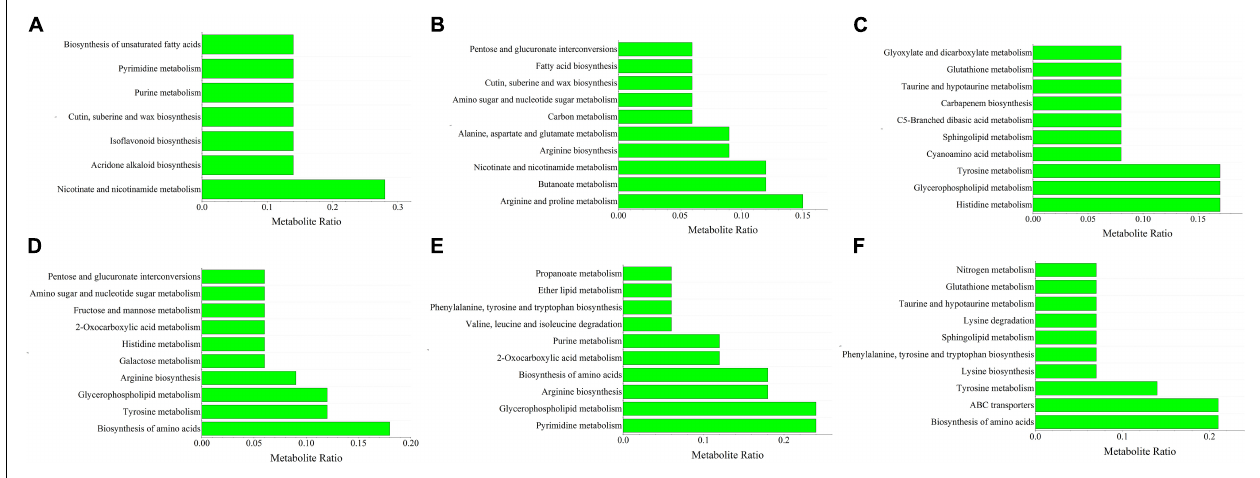
FIGURE 4 | Top 10 metabolites ratio of S1 vs. S22 (A) , S1 vs. S28 (B) , S1 vs. S49 (C) , R1 vs. R22 (D) , R1 vs. R28 (E) , and R1 vs. R49 (F) . 1, Control; 22, Ri + Pf + Th; 28, Fo; 49, Ri + Pf + Th +